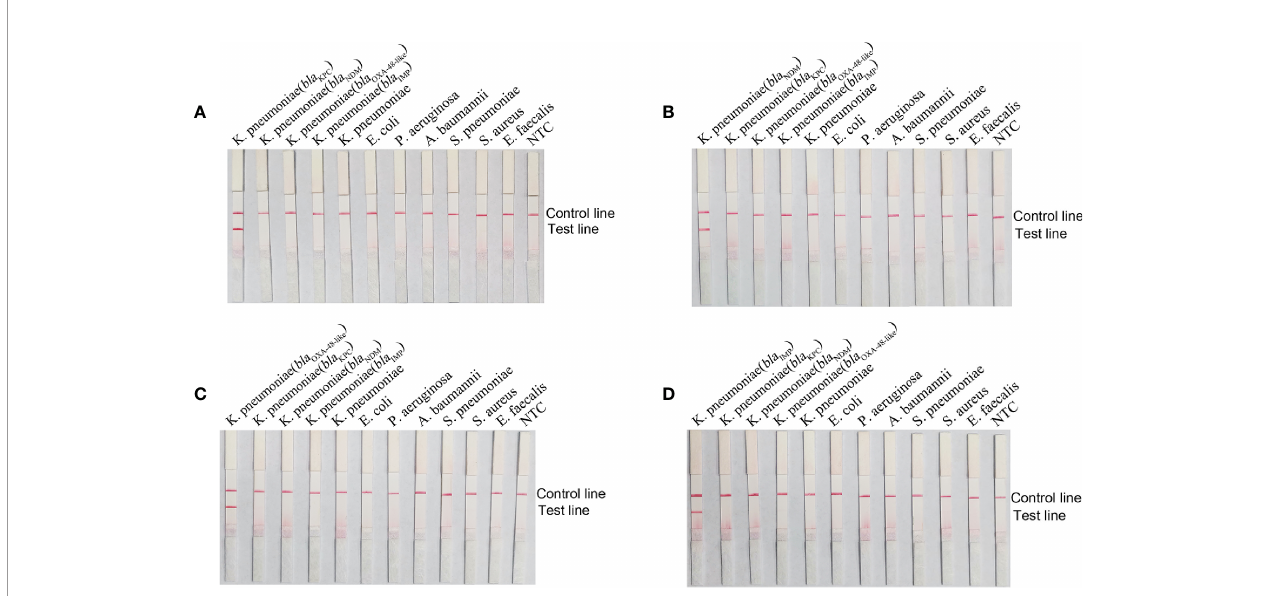
FIGURE 4 | Speci fi city of the RPA-LFS reaction system. The name of the template added to each reaction is labeled above the corresponding band. Primer-probe combinations of